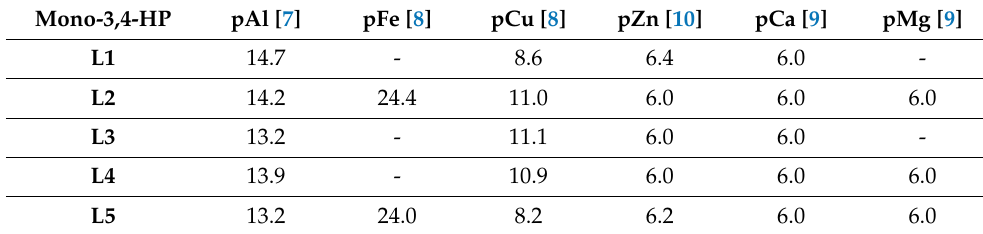
Table 1. pM values reported in literature for the